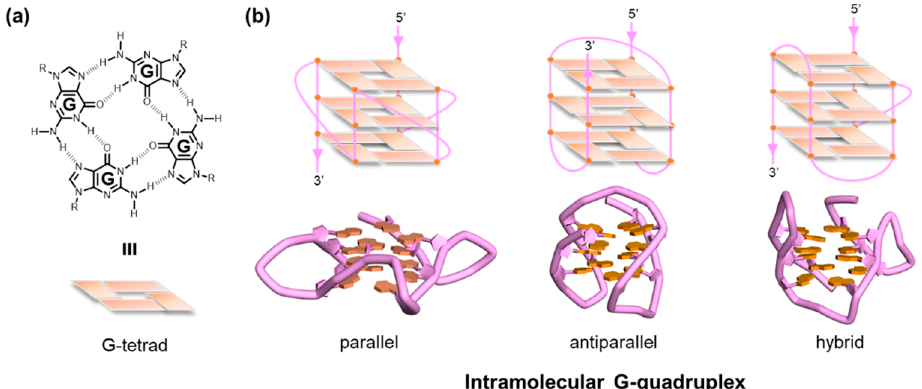
Figure 1. ( a ) Structure and schematic illustration of a G-tetrad. ( b ) Schematic illustrations of typical intramolecular G-quadruplex (G4) structures: (left) crystal structure of parallel type telomere G4 (PDB code: 1kf1); (center) solution structure of antiparallel type telomere G4 (PDB code: 143d); (right) solution structure of hybrid type telomere G4 (PDB code: 2gku). The figures were adapted with permission from Reference 56. PDB; Protein Data Bank.